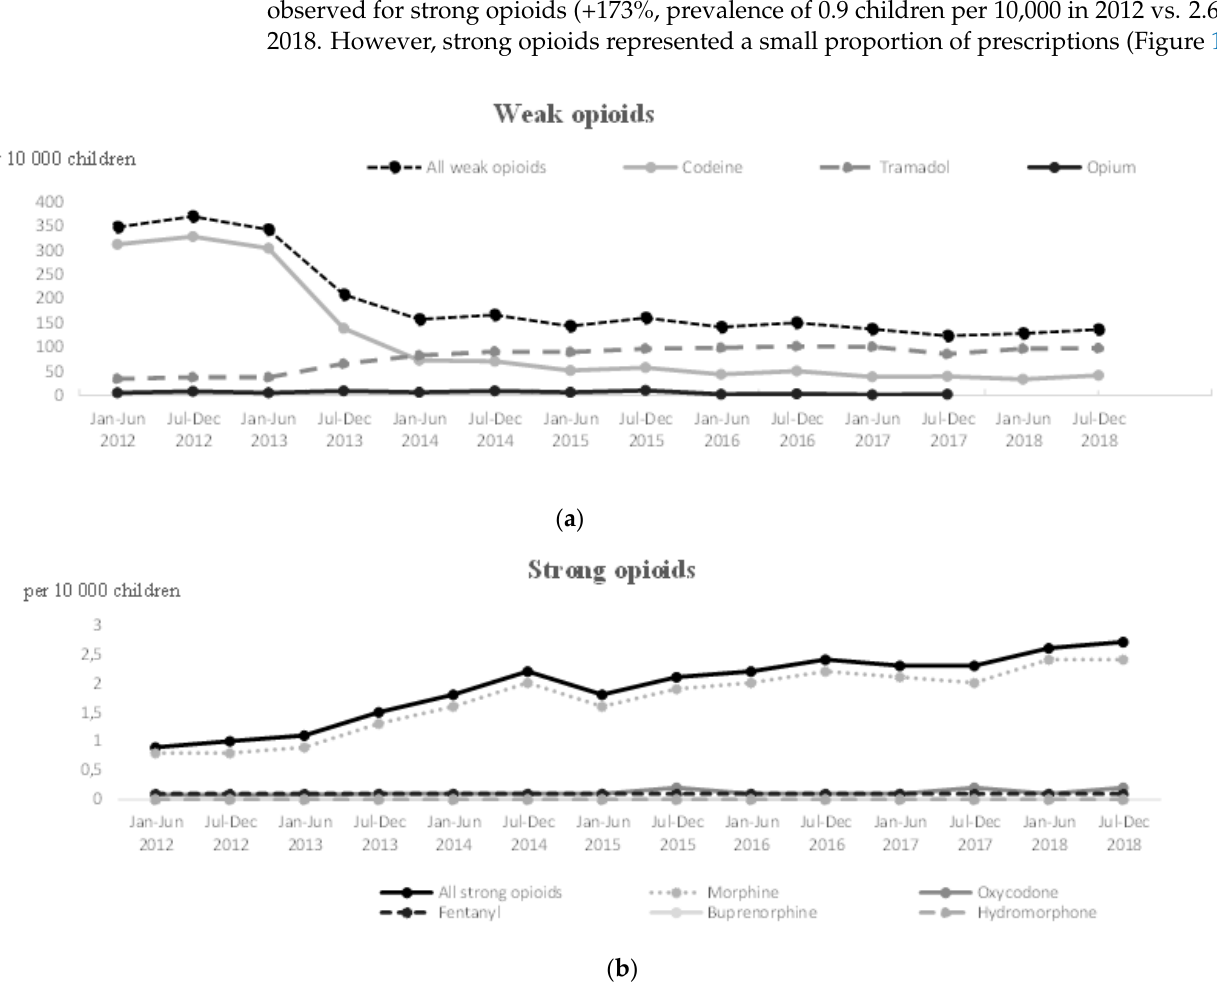
Figure 1. Trends of opioids use in children aged from 0 to 15 years between 2012 and 2018. ( a ) For weak opioids; ( b ) for strong opioids.